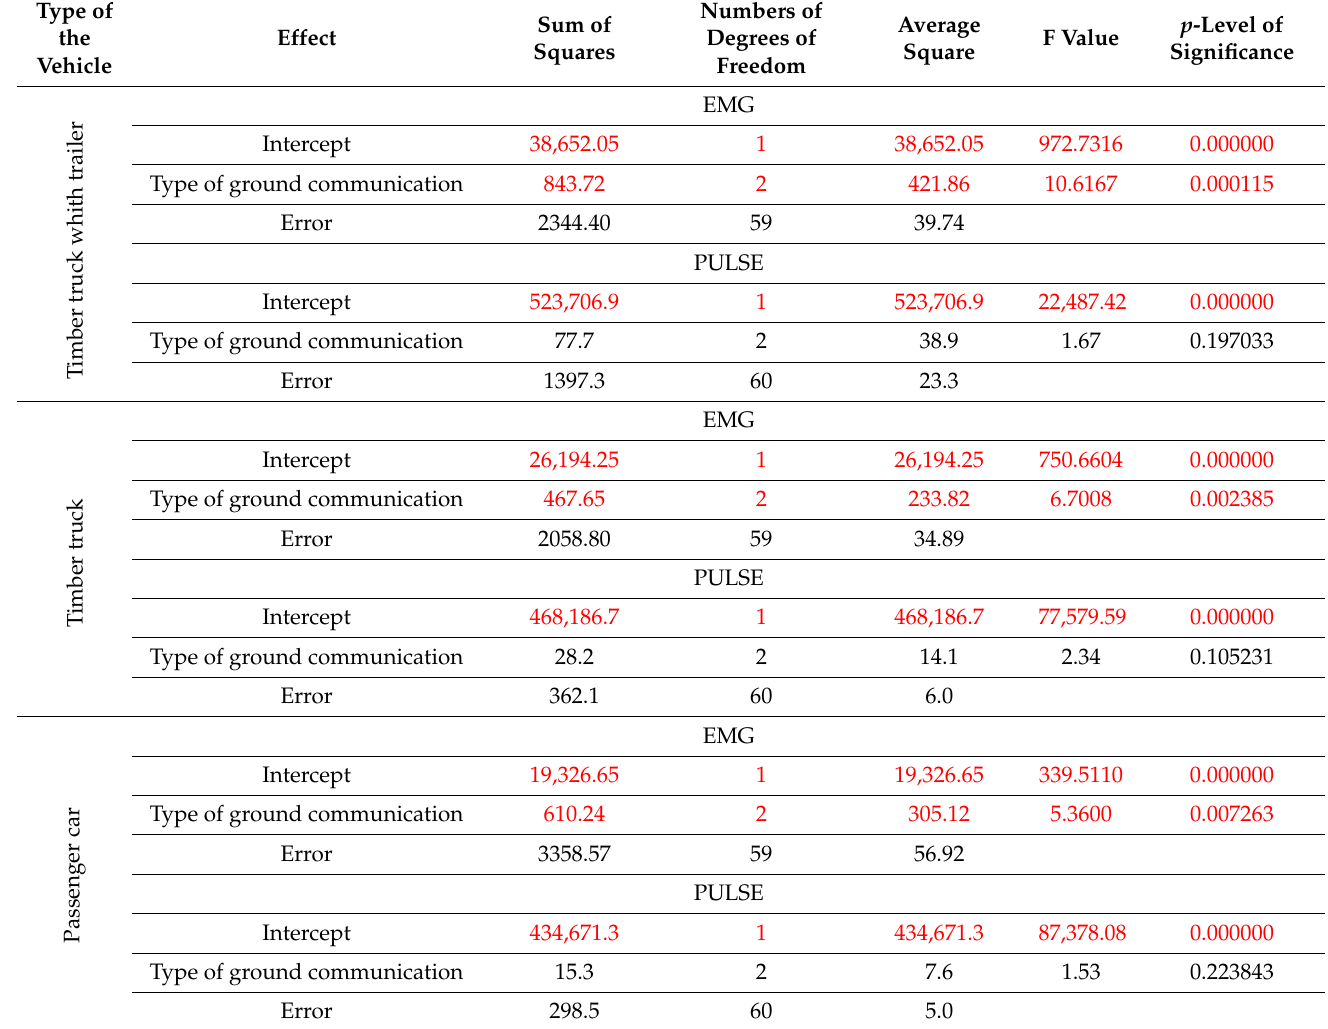
Table 4. Analysis of the variance of values of the dependence of muscle load and heart ratevalues on the type of ground communications and on the type of vehicle used. The red text indicates statistical